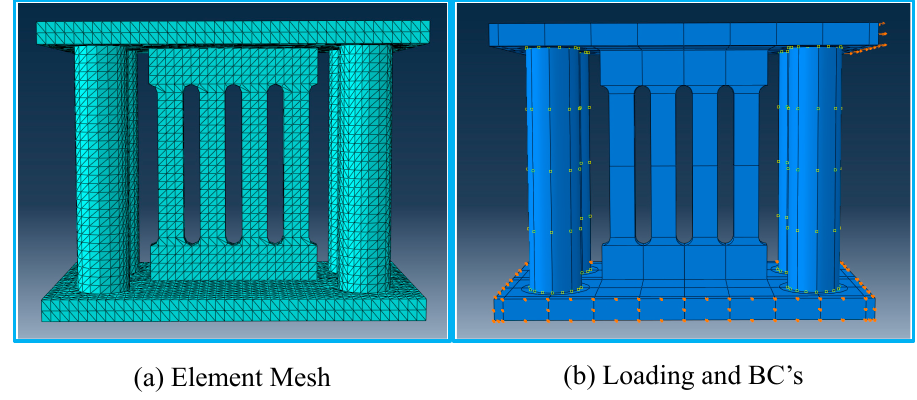
Figure 7. 3D finite element (FE) analysis models for the recentering slit damper system, ( a ): Element Mesh; ( b ): Loading and